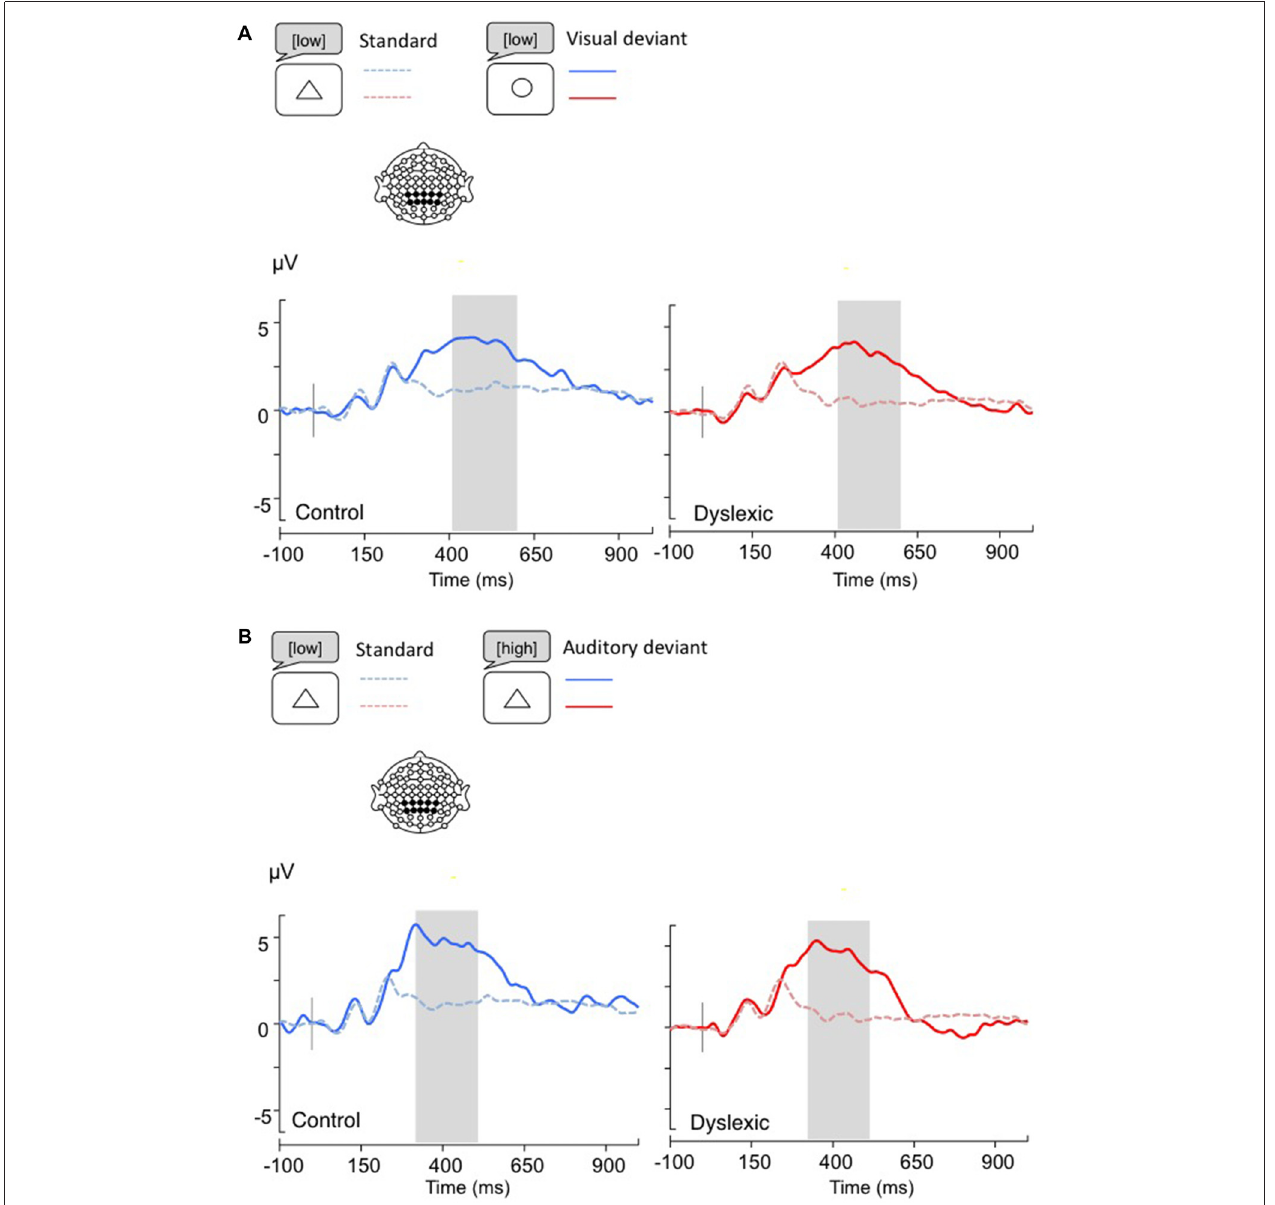
FIGURE 5 | Linear derivations over the electrodes where the P3b was maximal for typical and dyslexic readers’ responses in correct trials (Gray bar: analysis window). (A) Visual deviants; (B) Auditory deviants.